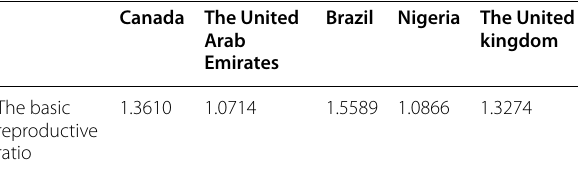
Table 2 Basic reproductive ratio of the 2022 outbreak of